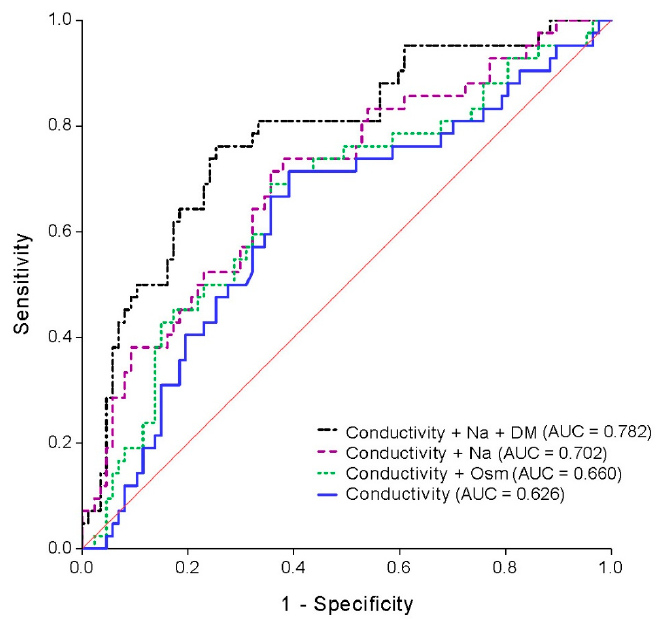
Figure 4. The receiver operating characteristic curve analysis. The receiver operating characteristic curves were built from four prediction models for the diagnosis of cardiomegaly. The area under the ROC curve (AUROC) was equal to 0.626 (95% CI: 0.521–0.730, p = 0.02) when salivary conductivity was the predicting factor. The combination of salivary conductivity, serum sodium, and history of diabetes mellitus showed a significant increase in AUROC (0.782, 95% CI: 0.696–0.868). Abbreviations: AUC, area under the curve; DM, diabetes mellitus; Na, serum sodium; Osm, serum osmolality.